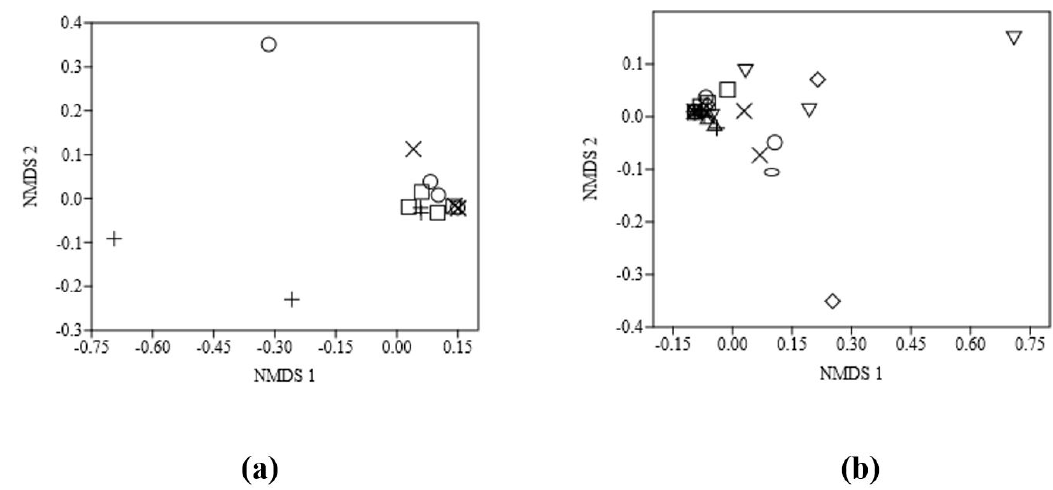
Figure 4. Non-Metric Multidimensional Scaling (NMDS) of the Plagioscion squamosissimus diet for the months (a) (+ February; □ May; X August; ○ November; 2011 - 2014) and sample points (b) (+ 1; □ 2; X 3; ○ 4;  5; ◊ 6,  7;  8; 2011 - 2014) at the Santa Cruz Reservoir, Rio Grande do Norte,